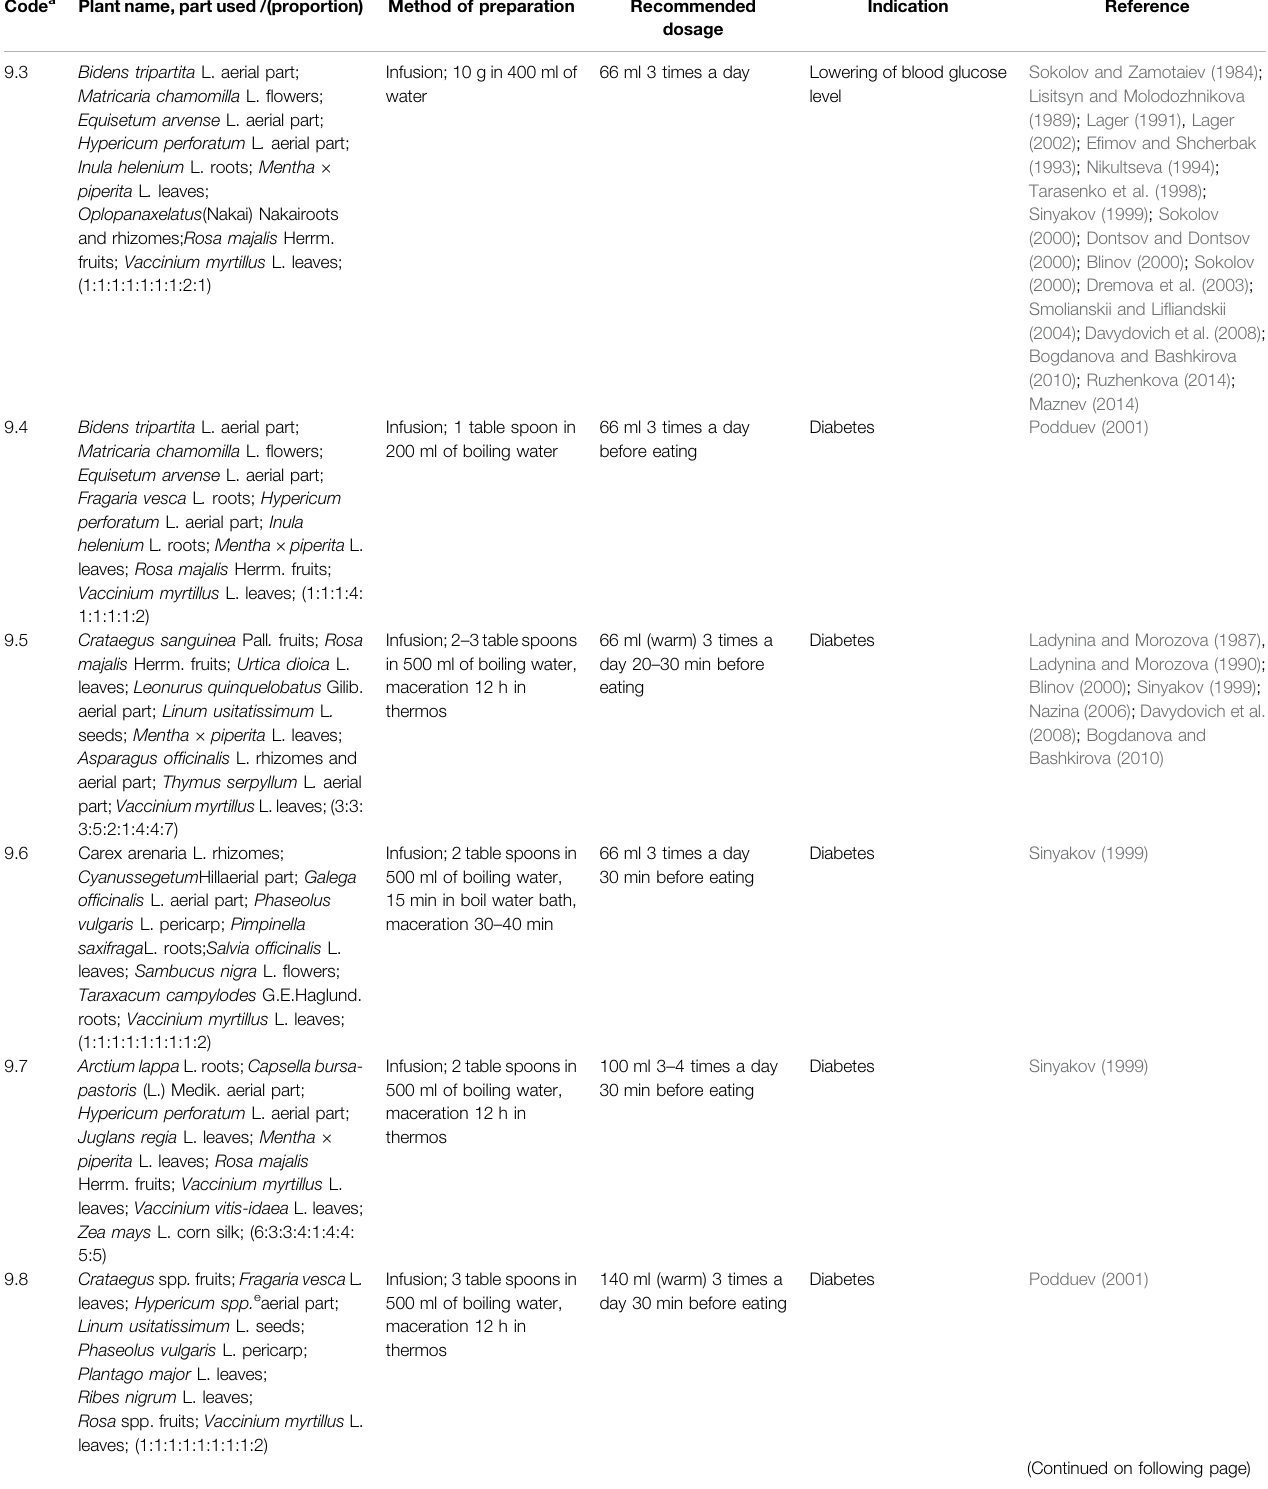
TABLE 1 | ( Continued ) The list of medical species used for the management of diabetes and related disorders in Russia. Code a Plant name, part used /(proportion) Method of preparation Recommended